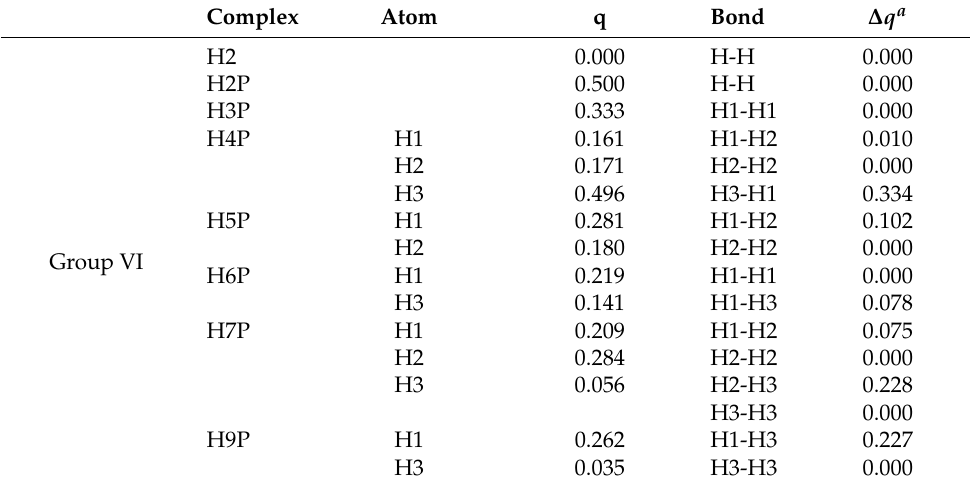
Table 3. NBO charges (e) for the hydrogen